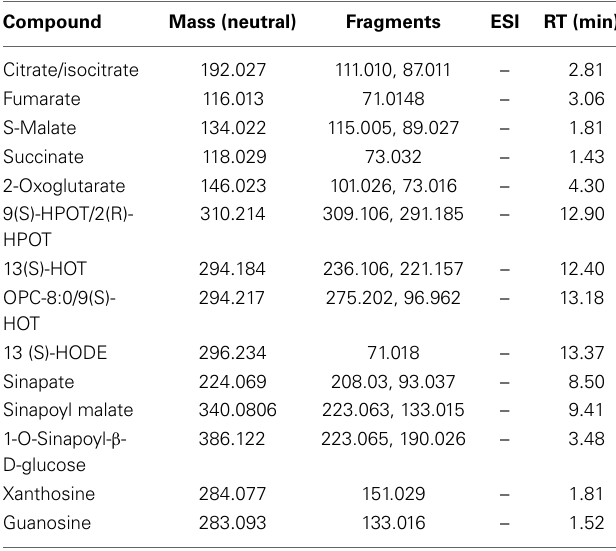
Table 1 | List of compounds identified by exact mass and fragmentation